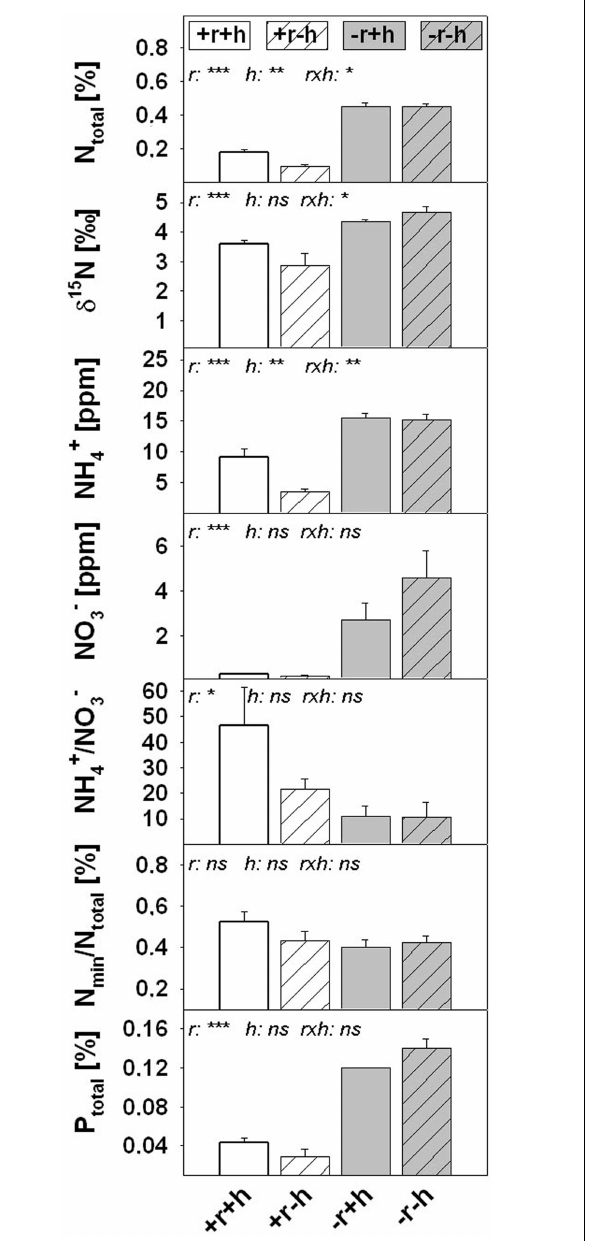
FIGURE 2 | Soil properties of the four restoration treatments in 2008 (see alsoTable 1A for comparison with data from earlier evaluations); parameters include N total and P total (concentrations [%] measured in bulk soil; fraction < 2mm) and mineral N forms [ammonium ( NH + ) , nitrate ( NO − ) measured in soil solution). Values are means ± 1 4 3 SEM ( n = 8 for N parameters, n = 2 for P total ). Restoration treatments: with topsoil removal and hay transfer ( + r + h , white bars), topsoil removal and without hay transfer ( + r − h , white striped bars), no topsoil removal and with hay transfer ( − r + h , gray bars), no topsoil removal and without hay transfer ( − r − h , gray striped bars). Significant effects of restoration treatments ( r = topsoil removal, h = hay transfer, r × h = interaction between both factors) on soil properties are shown as * p <